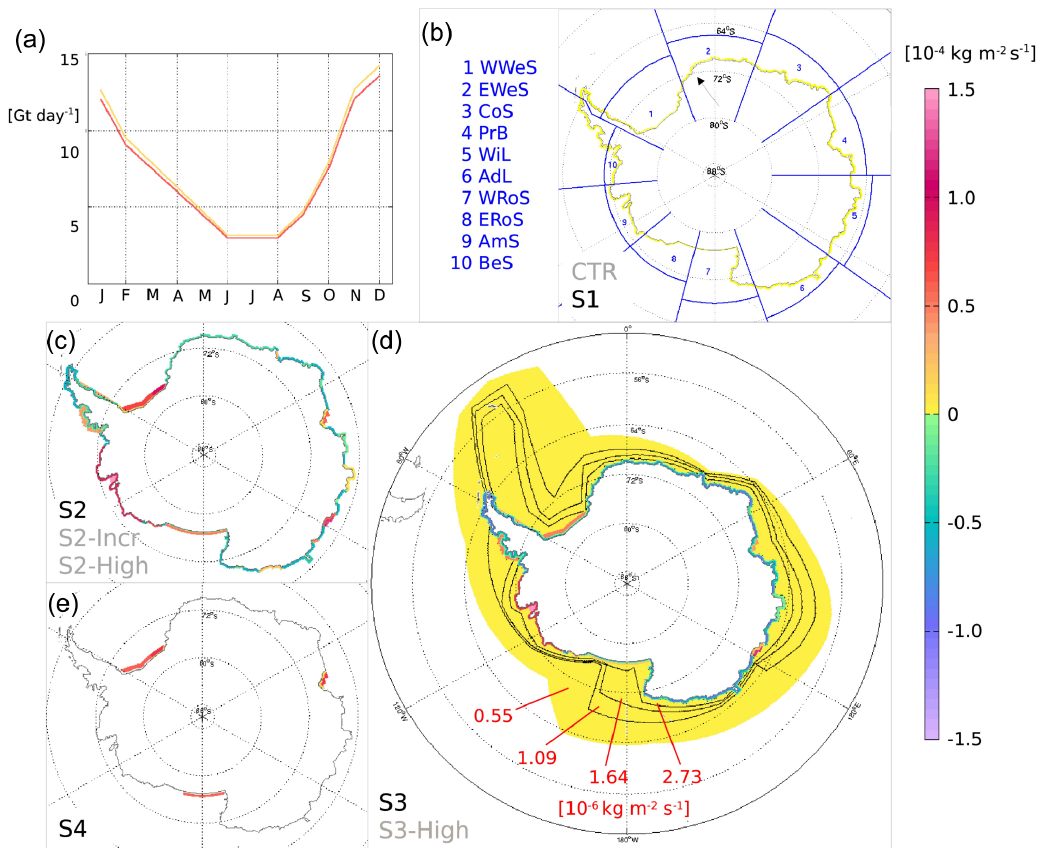
Figure 1. (a) Seasonal cycle of the runoff, with the example of CTR (red) and S1 (yellow); (b–e) runoff distributions for the scenarios as differences from the CTR runoff. The numbers vary with the seasonal cycle; shown is the mean for the winter half of the year (April– September). CTR (S2-Incr, S2-High) has a similar distribution to S1 (S2) but different values. (b) also depicts the location of Princess Martha coast marked with a black arrow and the definition of the regions used in the article: 1 WWeS – western Weddell Sea; 2 EWeS – eastern Weddell Sea; 3 CoS – Cosmonaut Sea; 4 PrB – Prydz Bay; 5 WiL – Wilkes Land; 6 AdL – Adelie Land; 7 WRoS – western Ross Sea;